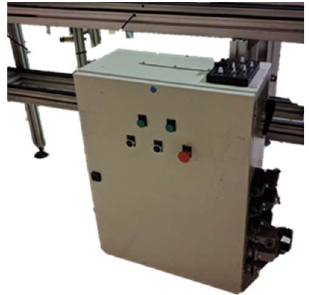
Figure 8. ZE200 and R200 automaton modules.